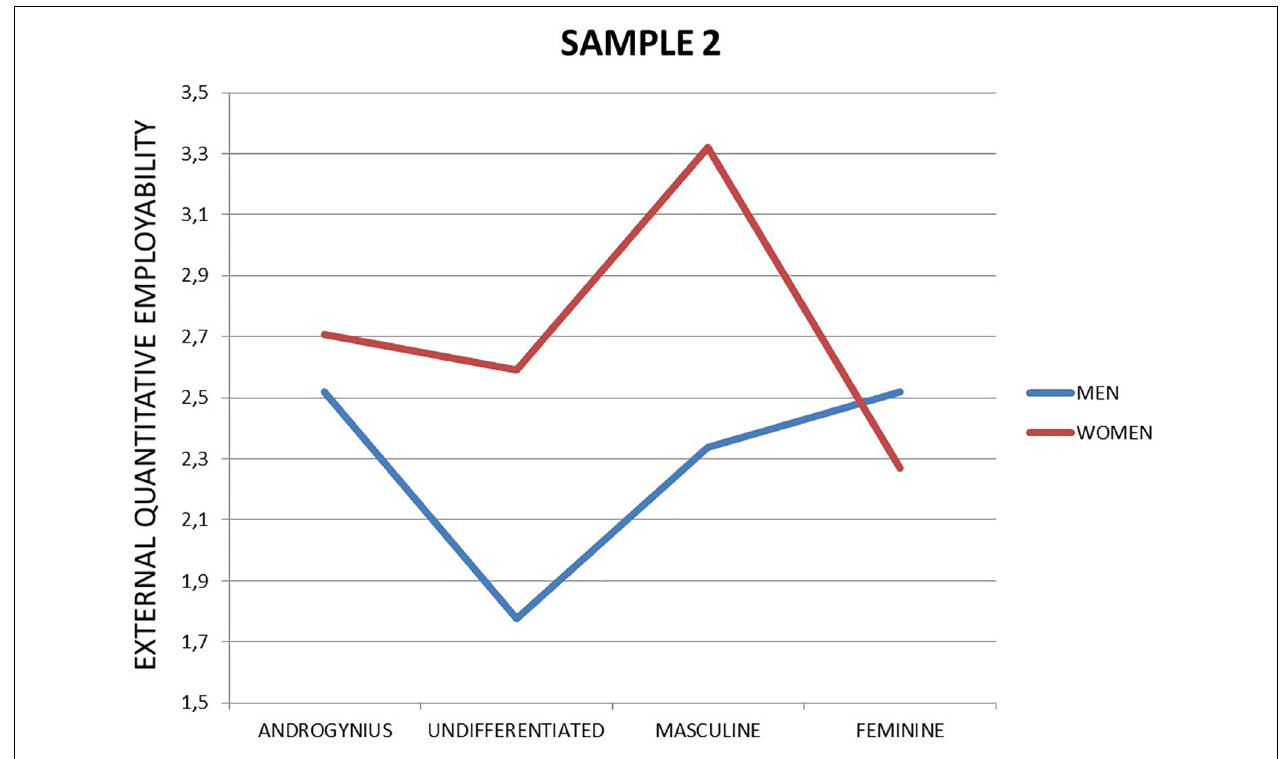
FIGURE 1 | External quantitative employability among unemployed (Sample